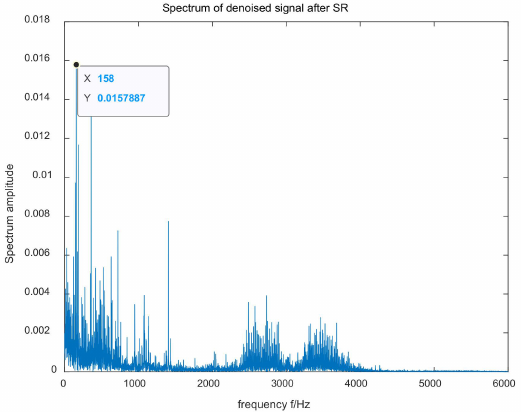
Figure 8. The output signal processed by the mentioned method for the Western Reserve University